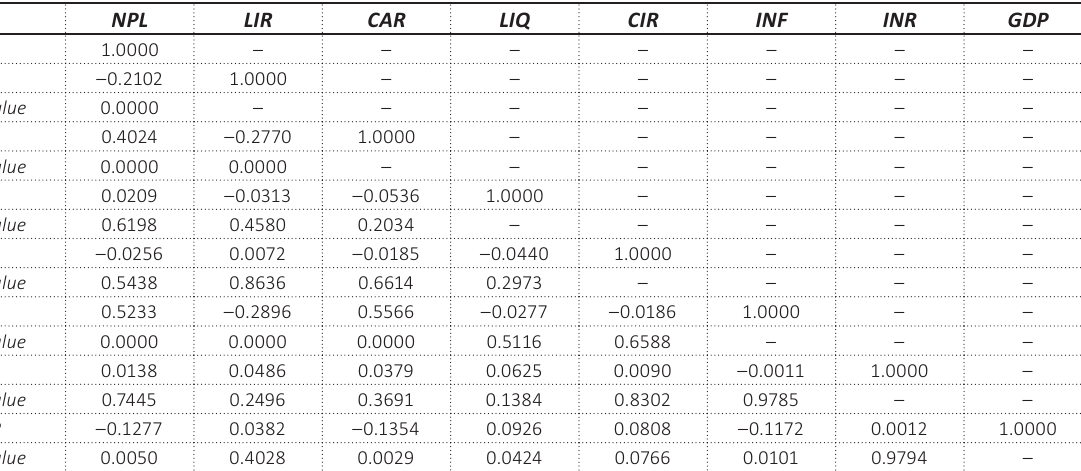
Table 4. Correlation analysis